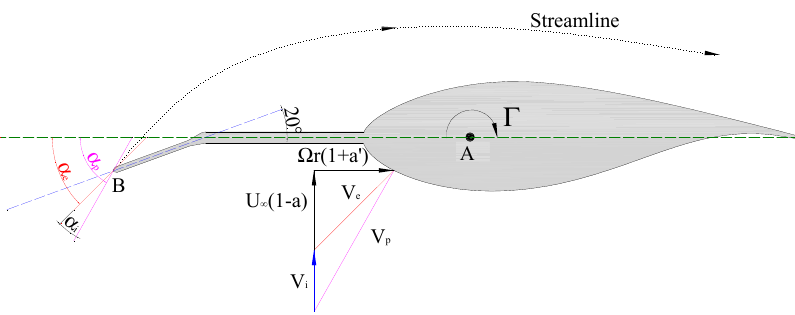
Figure 9. Effective angle of attack measured by leading-edge probe.